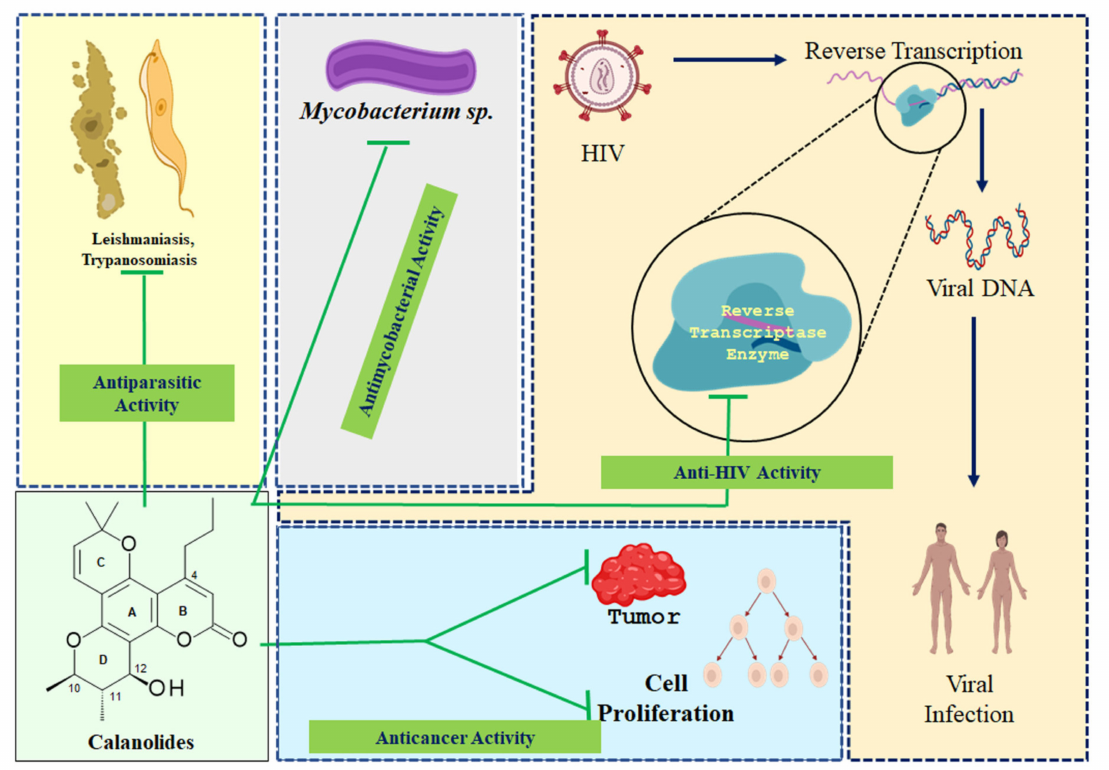
Figure 3. A pictorial summary of pharmacological properties of naturally occurring